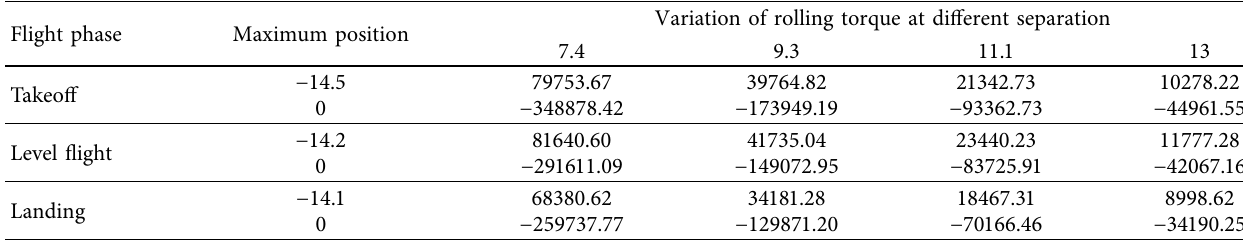
Figure 10: Variation of rolling moment in takeoff stage when encountering double vortex. (a) Takeoff phase. (b) Level flight phase. (c) Landing Table 8: Maximum value of double vortex rolling moment encountered.